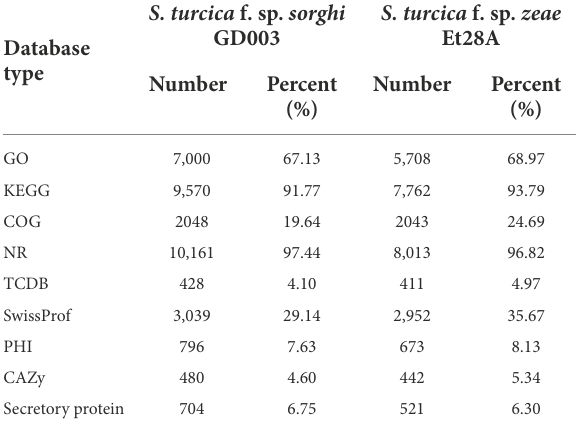
TABLE 1 Setosphaeria turcica f. sp. sorghi GD003 and S. turcica f. sp. zeae Et28A genome features. Features